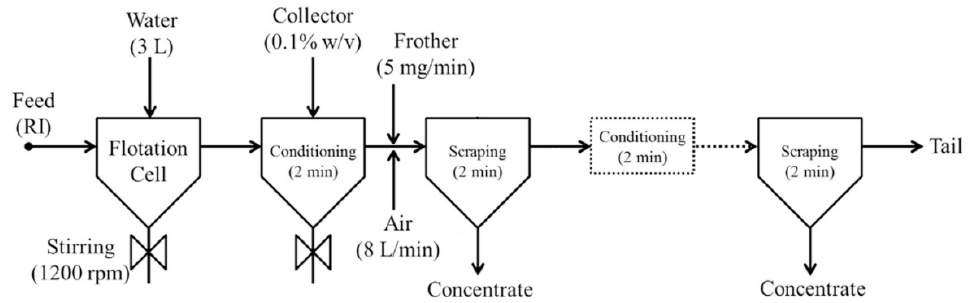
Figure 5. Schematic of the froth flotation separation process approach used in the study.